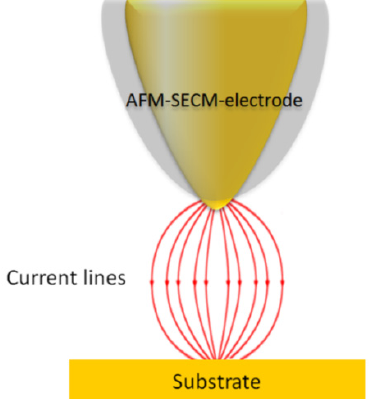
Figure 7. Schematic representation of the electric field between the AFM-SECM-electrode and the substrate.